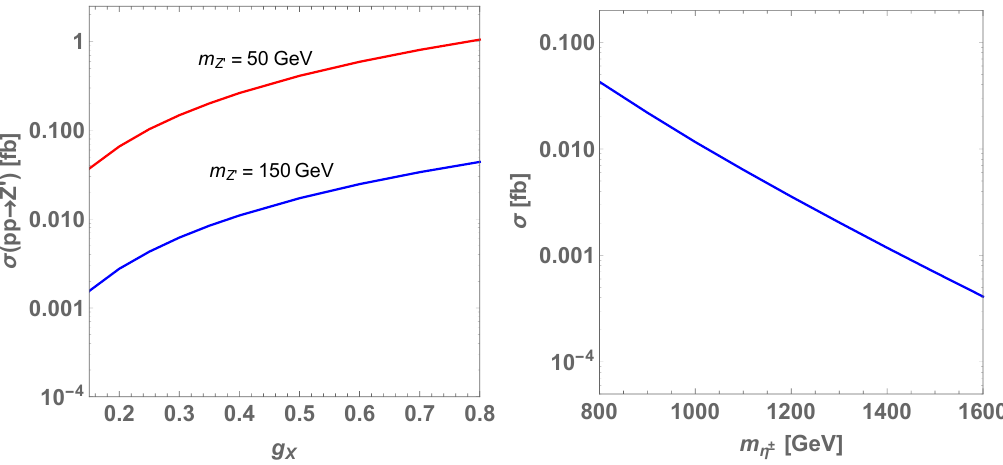
Figure 15 . Left: Z 0 production cross section at the LHC 14 TeV as a function of g X for m Z 0 = 50 and 150 GeV. Right: cross section for pp → η +